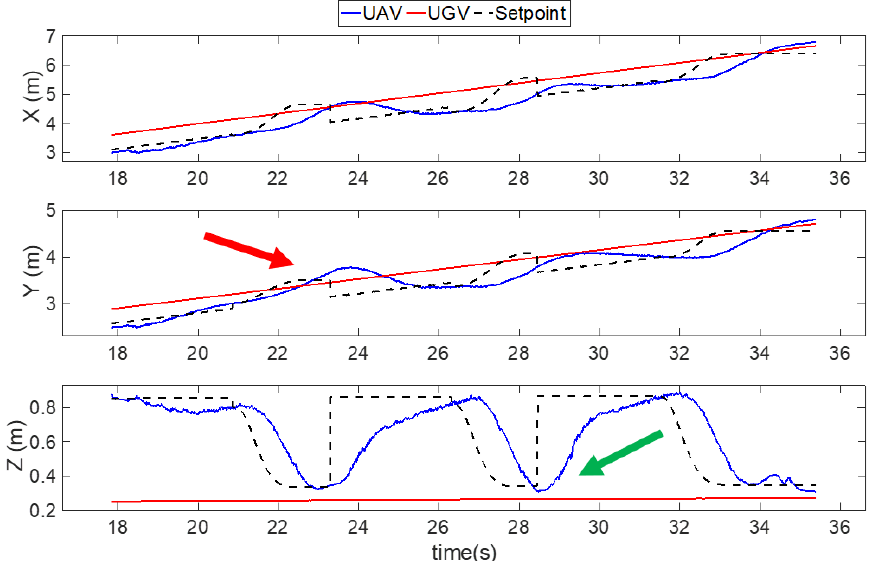
Figure 13. Position results of the UAV landing on a moving platform in an outdoor experiment. The red and green arrow show the overshoots of the UAV in experiment, which cause the failsafe to trigger.